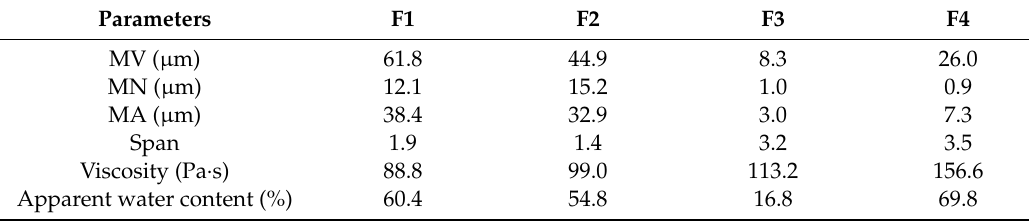
Table 2. Mean droplet size expressed in volume (MV), area (MA), and number (MN), span, viscosity, and apparent water content of the di ff erent HQ